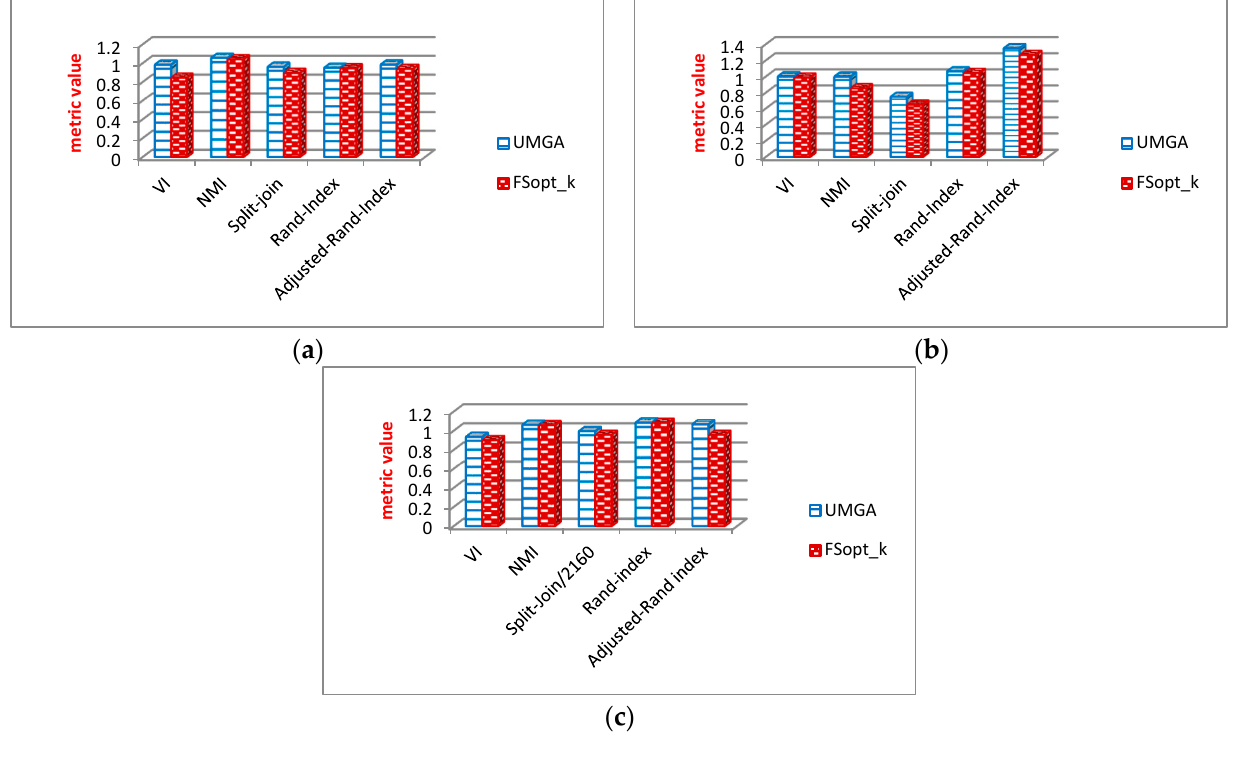
Figure 16. Evaluated values of community structure metrics on polbooks for ( a ): ℒ = 0.05 , ( b ): ℒ = 0.1 , and ( c ): ℒ = 0.2 .